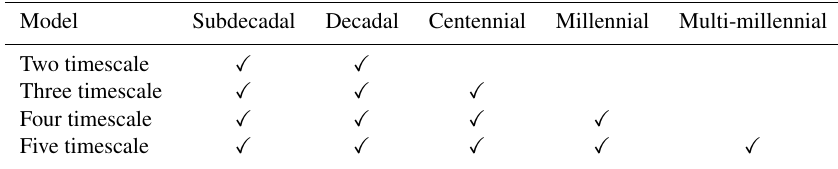
Table 1. Table showing the included modes from Table 2 for each model variant considered. Model